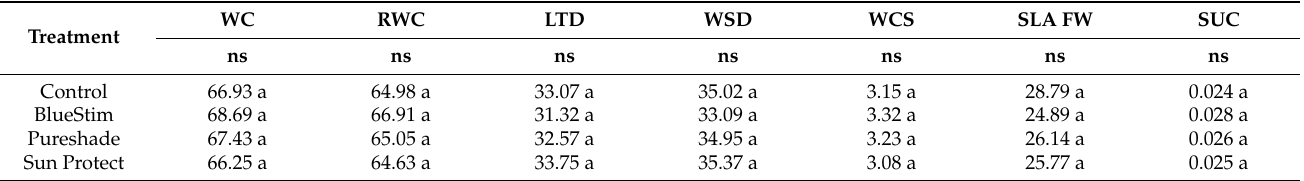
Table 3. Effects of the alleviating products on kiwifruit leaf sclerophylly indexes during the third sampling event on September 21st (WC, %; RWC, %; LTD, g kg − 1 ; WSD, %; WCS, g H 2 O g − 1